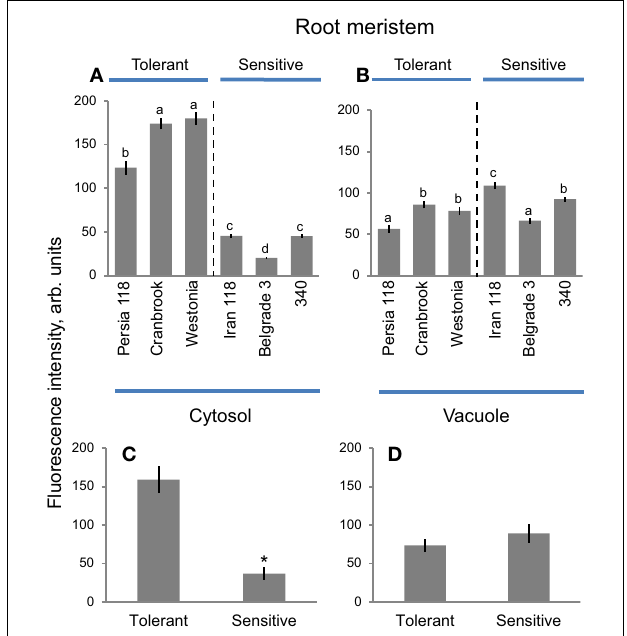
FIGURE 7 | Na + accumulation and patterning between cytosol and vacuole in meristematic root zone in bread wheat genotypes. Intensity of CoroNa Green fluorescence in cytosolic (A) and vacuolar (B) compartments (arb. units) in root meristem of six bread wheat varieties contrasting in their salinity tolerance. Mean ± SE ( n = 72–96 cells from at least six individual plants). Different lowercase letters represents significant difference between varieties at P < 0 . 05. (C,D) Averaged pooled values for cytosolic (C) and vacuolar (D) Na + intensity for salt-tolerant and salt-sensitive clusters shown in A , B . Mean ± SE ( n = 215 to 300; three varieties × 72–96 cells analyzed for each variety). Asterisk indicates significant difference between clusters at P < 0 . 01.